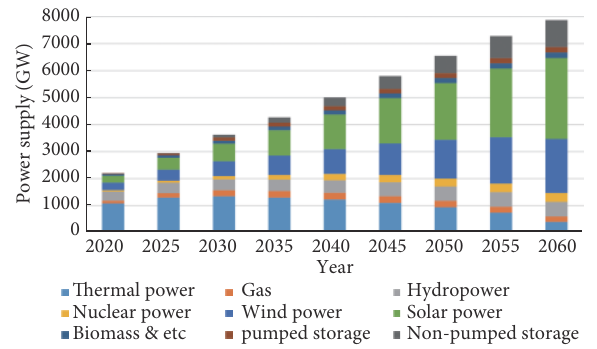
Fig. 3 Share of electricity in end-user energy consumption [4] .